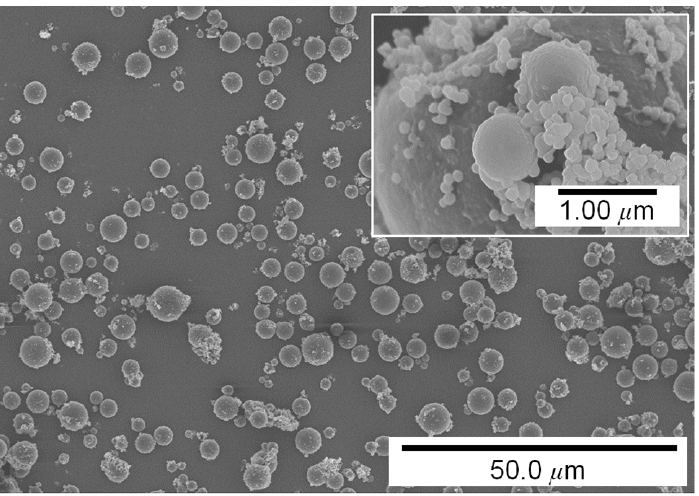
Figure 1. Thermochromic pigment powders.